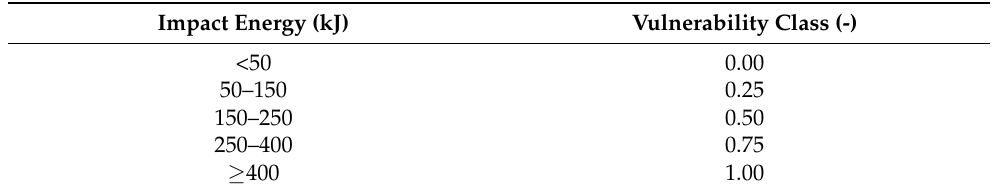
Figure 8. Vulnerability function according to [26]. Table 3. Vulnerability levels for buildings. The values depend on the impact energy and are obtained by the application of the [26] relationship.